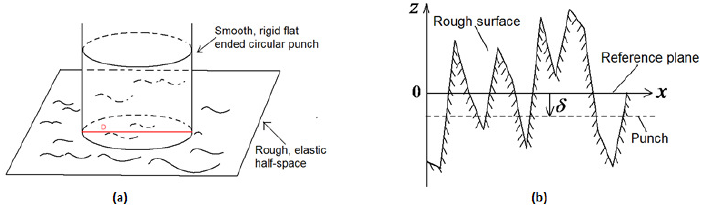
Figure 9. (a) The general profile of rough surface contact; (b) Undeformed state in 1D